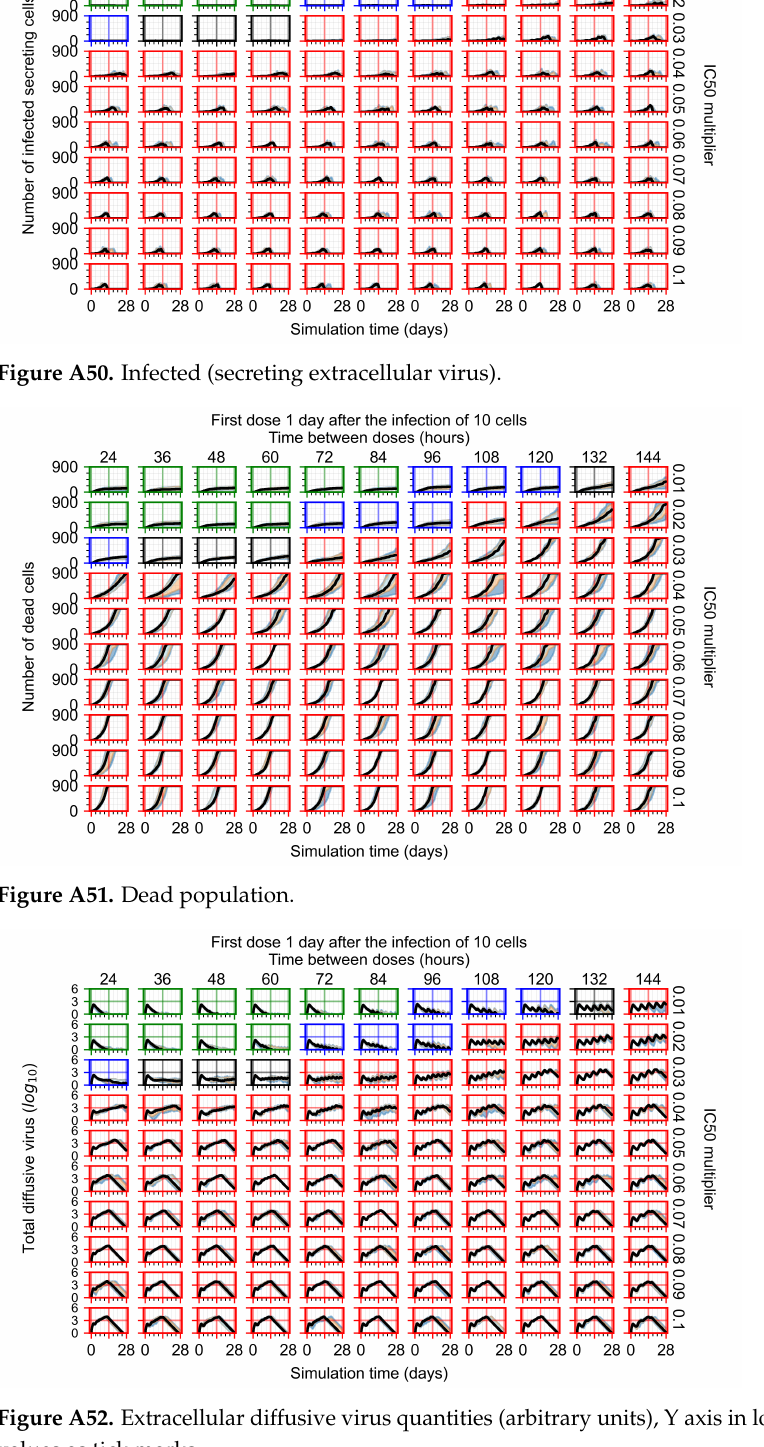
Figure A52. Extracellular diffusive virus quantities (arbitrary units), Y axis in log scale, and exponent values as tick